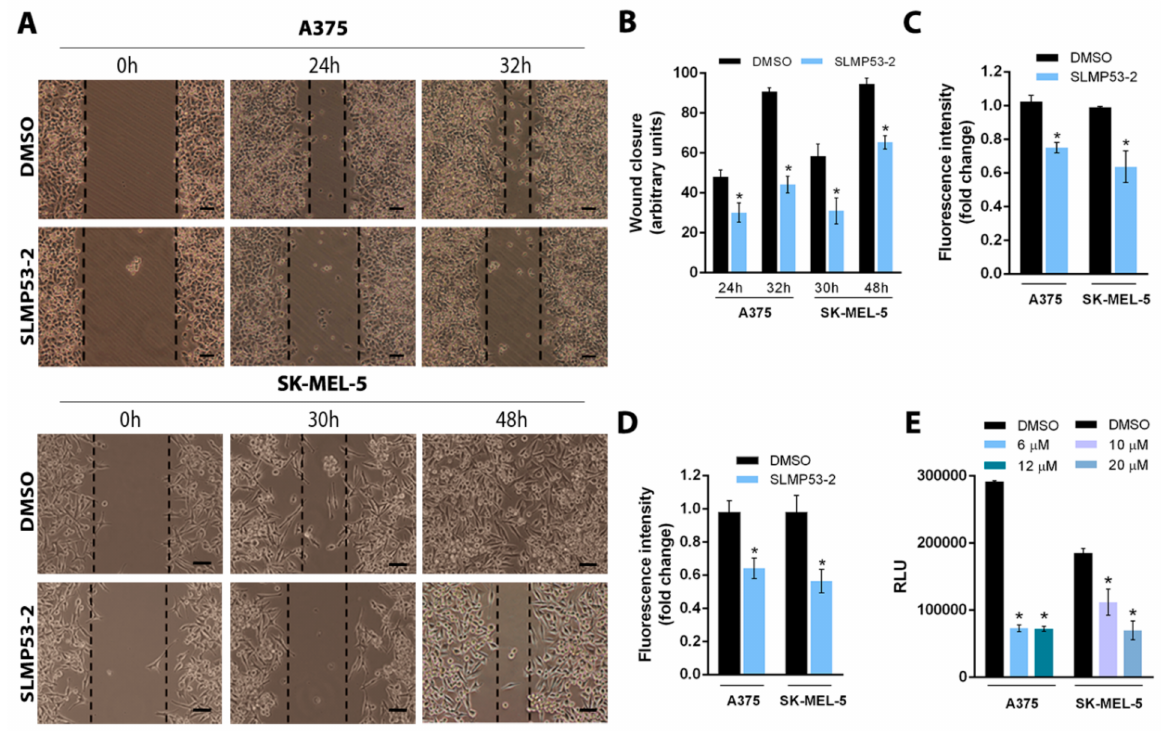
Figure 4. SLMP53-2 inhibits melanoma cell migration and invasion. ( A ) A375 and SK-MEL-5 confluent cells were treated with 2 or 4 µ M SLMP53-2, respectively; cells were observed at 24 and 32 h (A375) and 30 and 48 h (SK-MEL-5) in the wound- healing assay. Images are representative of five independent experiments; scale bar = 100 µ M; magnification = 100 × . ( B ) Quantification of wound closure using randomly selected microscopic fields (six fields per sample). Data are mean ± SEM, n = 5; values are significantly different from DMSO: * p < 0.05, two-way ANOVA followed by Sidak’s test. ( C ) Effect of 2 µ M SLMP53-2 on migration of A375 and SK-MEL-5 cells after 24 h of treatment. The relative number of migratory cells was determined by analysis of fluorescence signal intensity; values with DMSO were set as 1. Data are mean ± SEM, n = 5 (two replicates each); values are significantly different from DMSO: * p < 0.05, Student’s t -test. ( D ) Effect of 2 µ M SLMP53-2 on the invasion of A375 and SK-MEL-5 cells after 24 h of treatment. Cells able to invade through an ECMatrix layer were quantified by fluorescence signal; values with DMSO were set as 1. Data are mean ± SEM, n = 5 (two replicates each); values are significantly different from DMSO: * p < 0.05, Student’s t -test. ( E ) Effect of SLMP53-2 on lactate secretion by A375 and SK-MEL-5 cells after 8 h of treatment. Cell density for each sample was used to normalize relative luminescence units (RLU) signal. Data are mean ± SEM, n = 5 (two replicates each); values are significantly different from DMSO: * p < 0.05; unpaired Student’s t